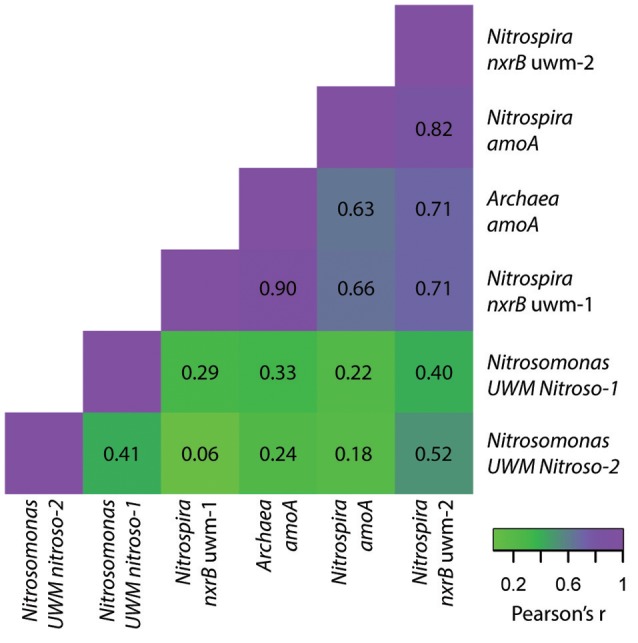
Heatmap of abundance pattern correlations for nitrifier genotypes. Pearson's correlation coefficient values (r) are listed and colored according to the strength of the abundance correlation between marker genes for each genotype. Purple colors indicate stronger correlations and green colors indicate weaker correlations.